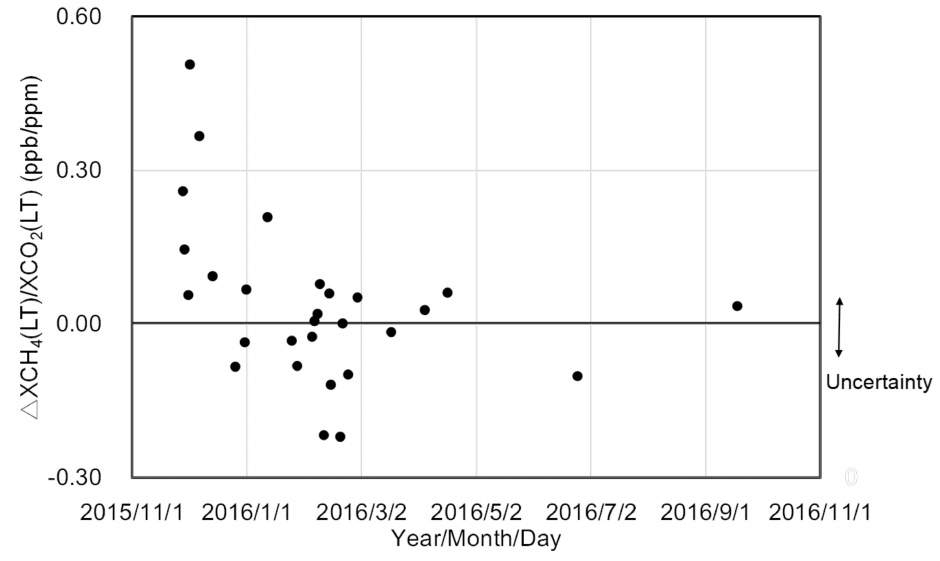
Figure 4. XCH 4 (LT) enhancements with time normalized with XCO 2 (LT) between the blowout and leak control. Data with wind direction of East–South–Northwest at the leak point were filtered